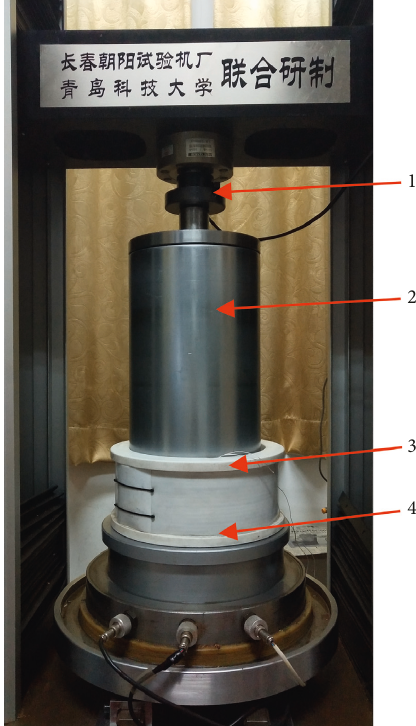
Figure 5: TAW-200 material mechanics testing machine. 1-stress loading device, 2-triaxial cell, 3-temperature sensor, and 4-elec- tromagnetic